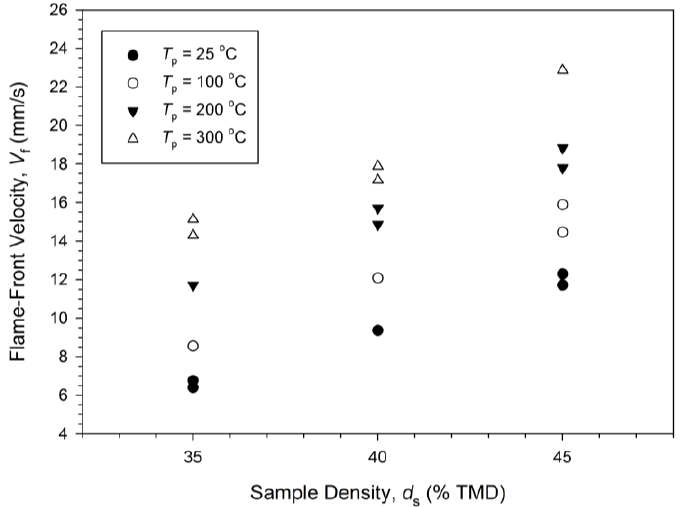
Figure 1. Solid state combustion propagating in a self-sustaining manner along a powder compact of Ta:Si = 5:3 with d s = 35% TMD and T p = 100 °C.